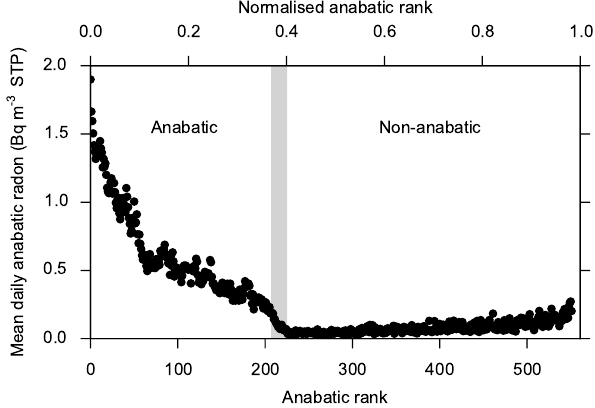
Figure 3. The daily mean anabatic radon concentration as a function of anabatic rank. Days with a rank above 220 (when the anabatic radon concentration first reaches its minimum) have a diurnal radon variation which is uncharacteristic of anabatic flows and are classi- fied as non-anabatic. The increase in anabatic contribution after the minima is an artefact of the